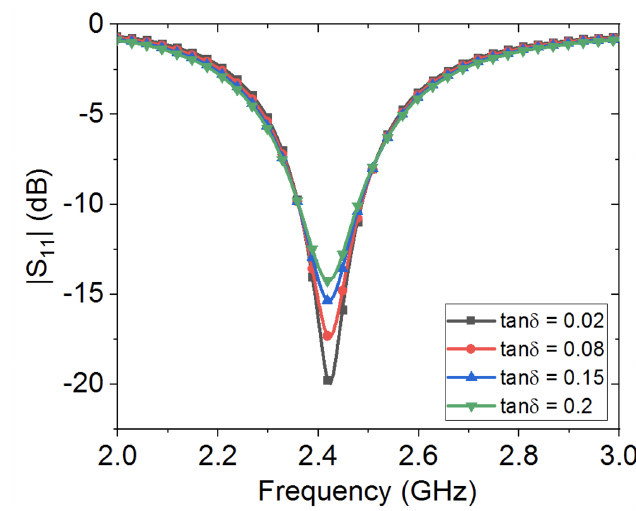
Figure 8. Numerical study of the effect of textile cotton fabric electrical loss, tan δ , on wearable loop antenna’s resonance frequency.